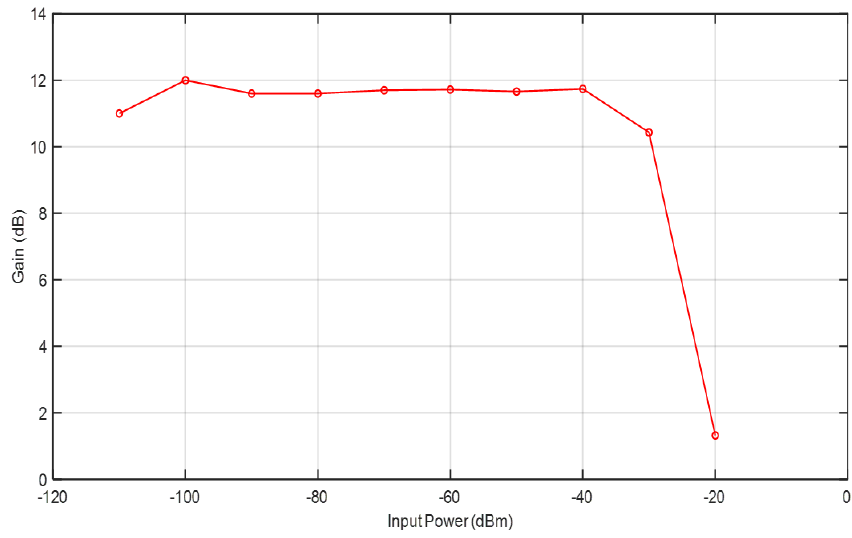
Figure 16. Gain behavior under input power variation.